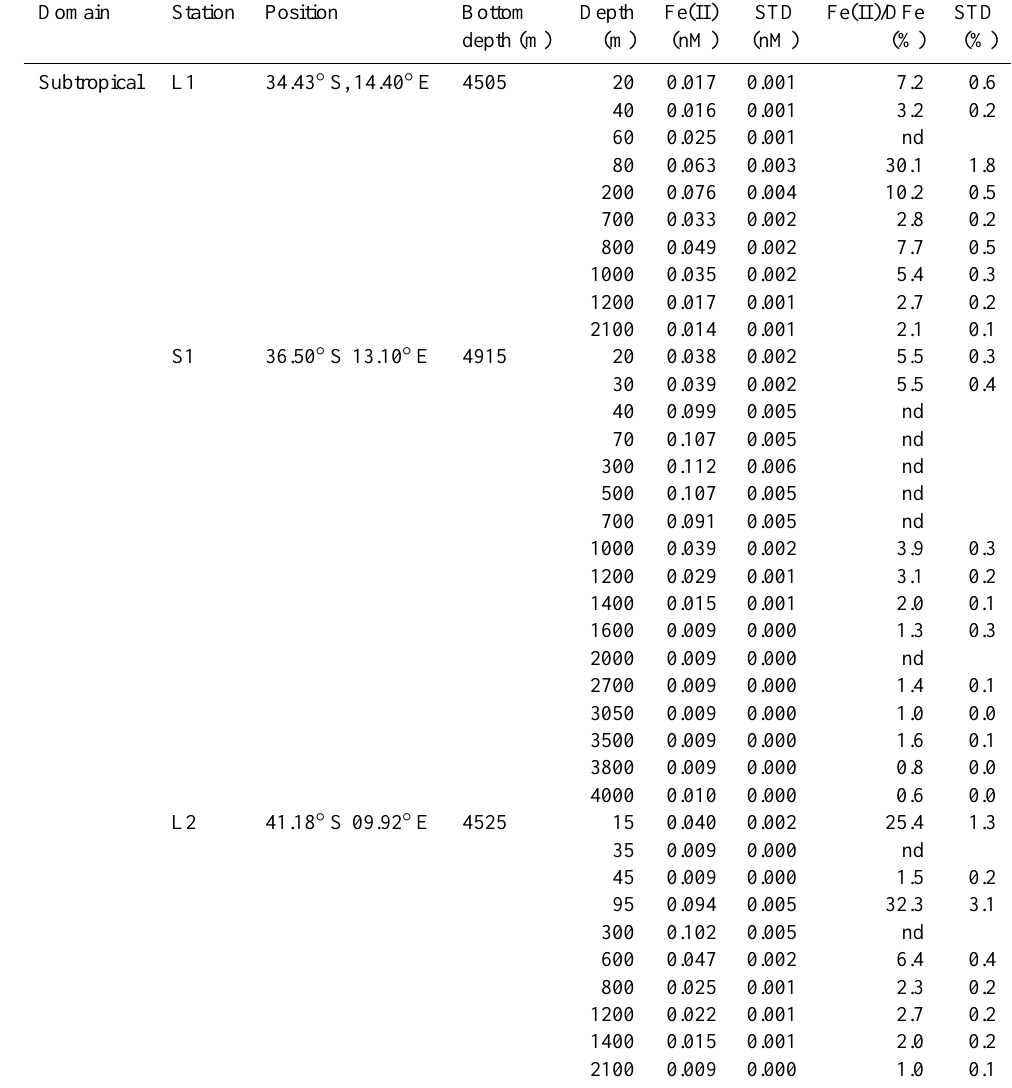
Table 2. Labile Fe(II) concentrations and percentage of labile Fe(II) over dissolved Fe (DFe, Chever et al., 2010). Uncertainties on the concentrations correspond to standard deviation of a same sample measured 3 times. EWSG=eastern part of the Weddell Sea Gyre. nd=not determined, when no DFe data were